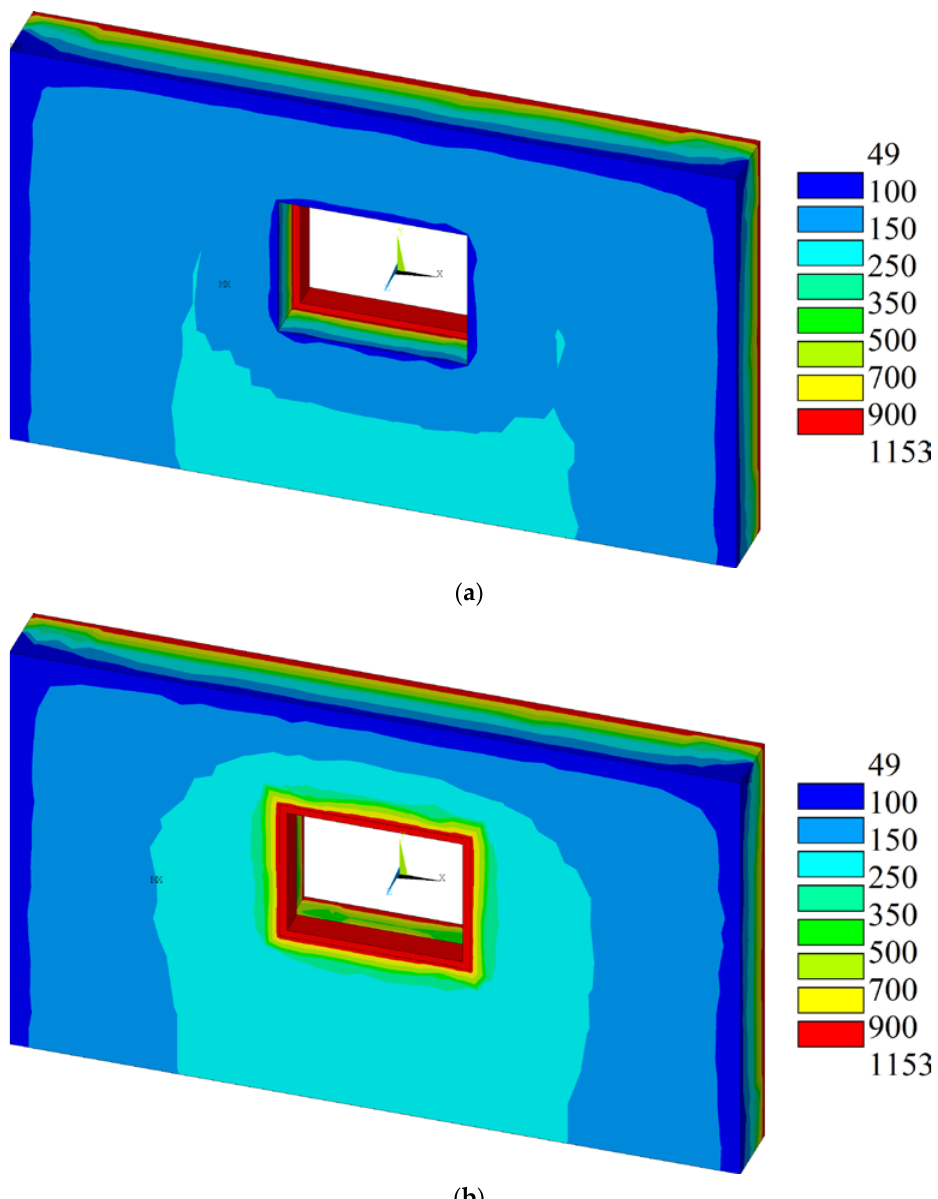
Figure 16. Analysis results for the W2B specimen, including an aluminum window frame, close to ( a ) the exposed and ( b ) nonexposed face and considering 240 min of exposure.